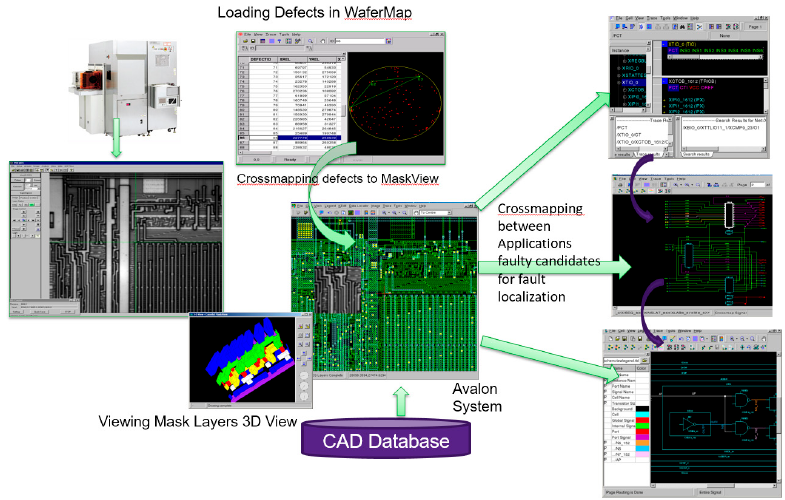
Figure 5. Avalon flow for fault localization.